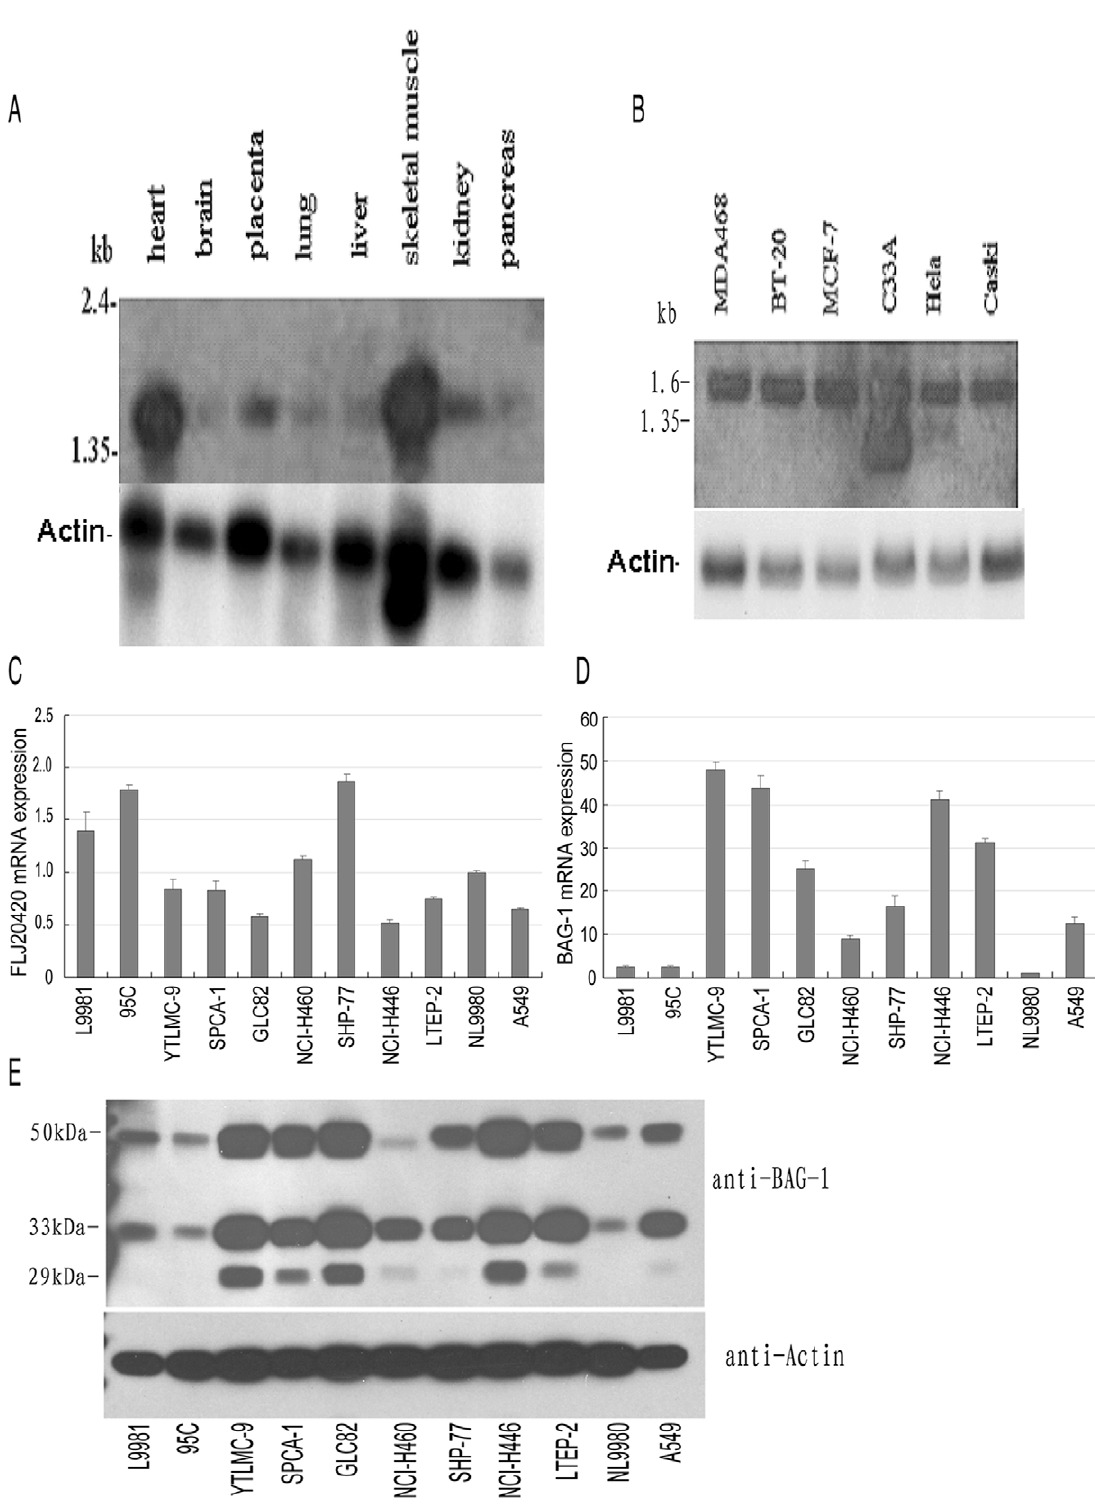
Figure 2. FLJ20420 mRNA expression in different tissues and cell lines. Northern blot analysis of FLJ20420 mRNA expression in human normal tissues (A) and various tumor cell lines (B). FLJ20420 cDNA was used as a probe. The number on the left side indicates the size of the molecular mass markers. The same blot was then stripped and re-probed with human actin probe as an internal control. (C-D) Real-time PCR analysis of FLJ20420 and BAG-1 mRNA expression in lung cancer cell lines. NL9980 cells were used as a calibrator. The expression of FLJ20420 opposed BAG-1 expression in these cell lines. Error bars are representative of an average of 2 triplicate RT-PCR experiments. (E) Immunoblot analysis shows that BAG-1 protein expression corresponds to BAG-1 mRNA expression in the cell lines analyzed.